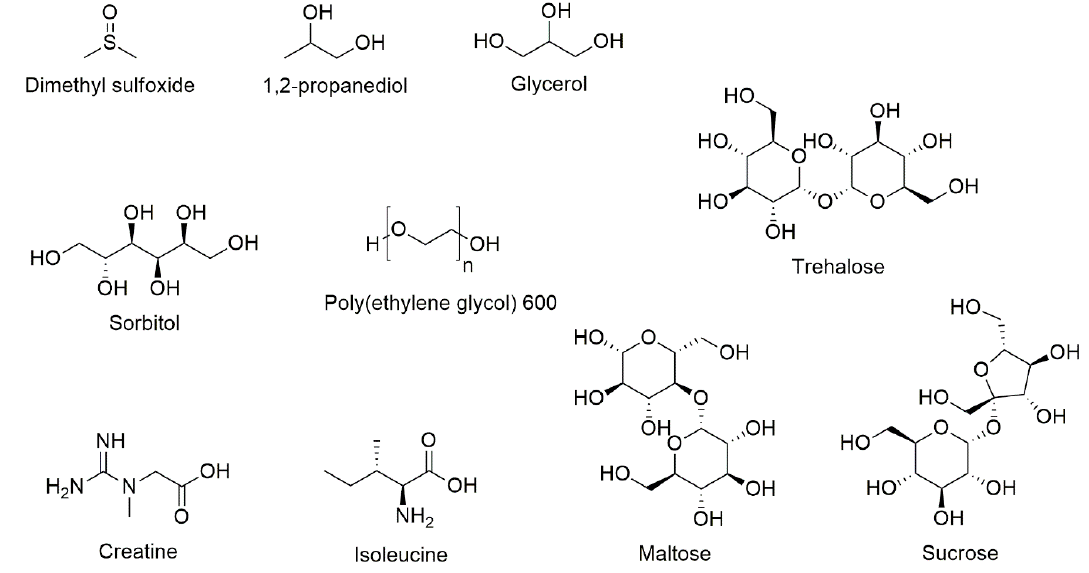
Figure 3. The chemical structures of excipients used in DMSO-free cryopreservation formulations of T cells. A parallel study focused on sucrose:glycerol:isoleucine compositions defined the optimal formulation to be 146 mM:10%:43 mM, as measured by post-thaw recovery (max. 84%) of Jurkat cells [106]. Given the current use of hyperosmolar 5–10% DMSO solutions for T cell cryopreservation, it is noteworthy that both studies show no significant correlation between osmolarity (from ca. 200 to 1600 mOsm/kg) and the post-thaw recovery of the Jurkat cells. A recent paper from the same group evinced that sucrose could be substituted for trehalose at the same concentration and ratio to glycerol:isoleucine to maintain the post-thaw recovery of Jurkat cells and PBMCs near equivalent to 10% DMSO [107]. Substitution of sucrose for maltose was equally effective,